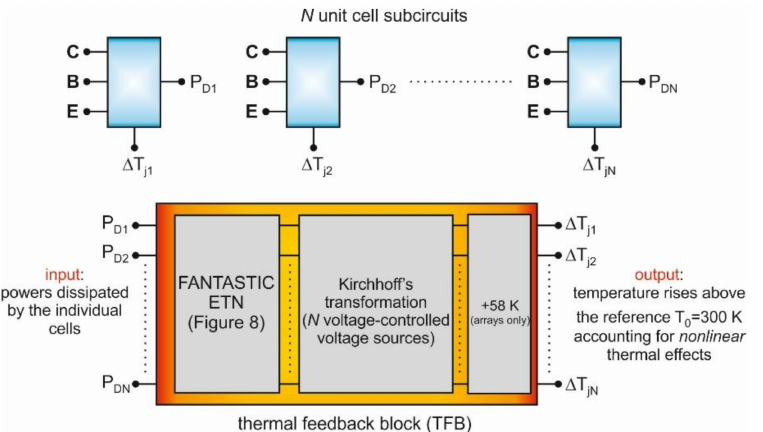
Figure 10. Sketch of the merely-electrical macrocircuit including ET effects through the TEOL. The paralleled (sharing the same base, emitter, collector contacts) subcircuits describing the unit cells are connected to the TFB containing: the ETN preliminarily evaluated by FANTASTIC, the calibrated Kirchhoff’s transformation, and a block adding 58 K (for the arrays